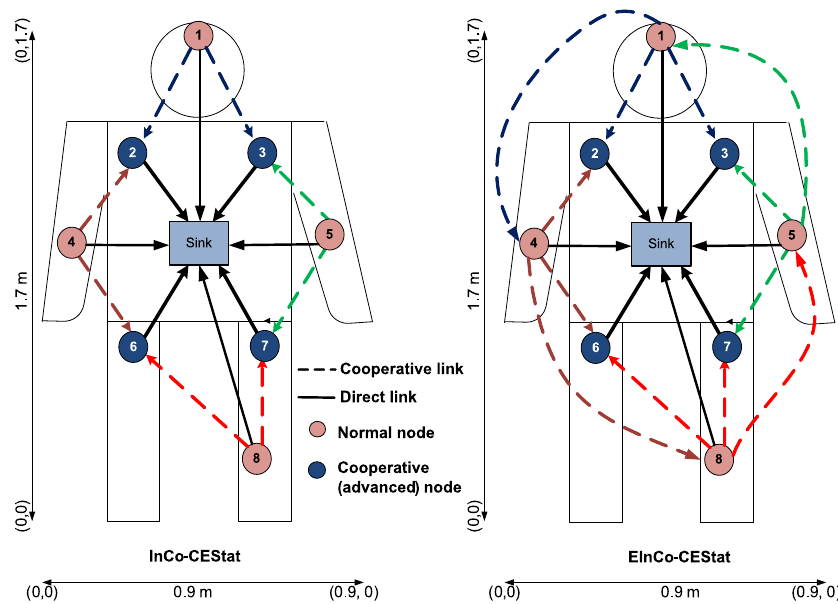
Figure 4. Network topology of incremental cooperative critical data transmission in emergencies for